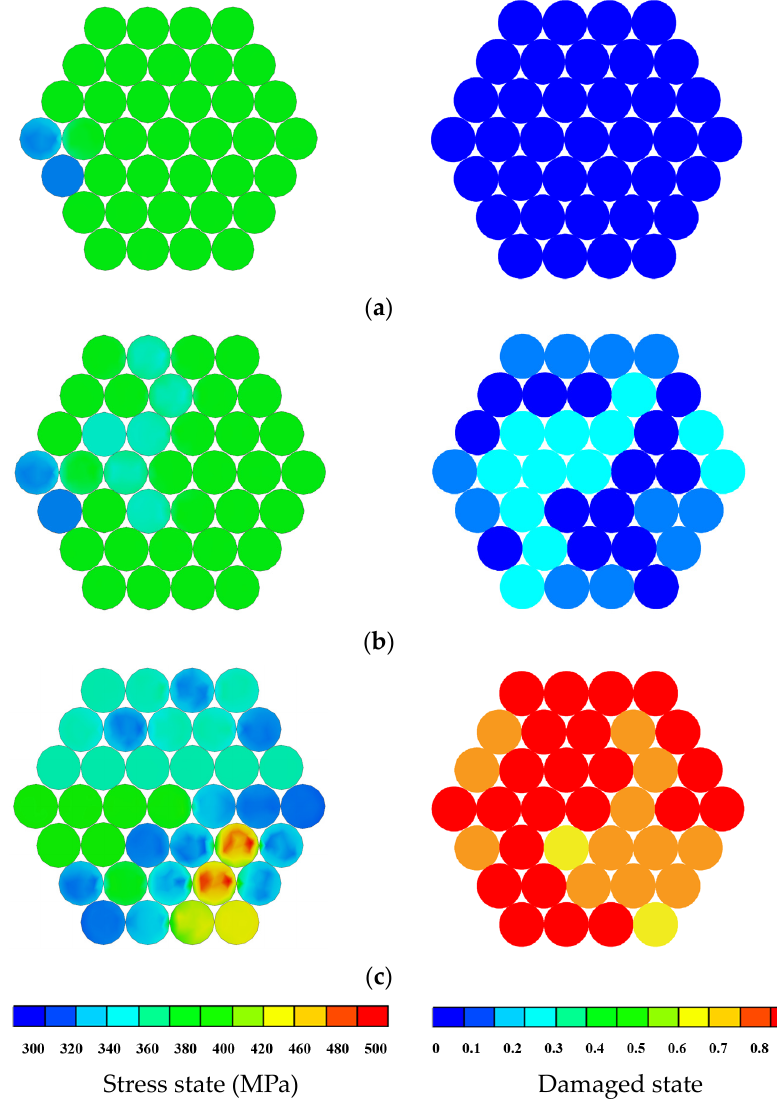
Figure 5. Changes of stress and damage distribution in the cable body during damage evolution. ( a )